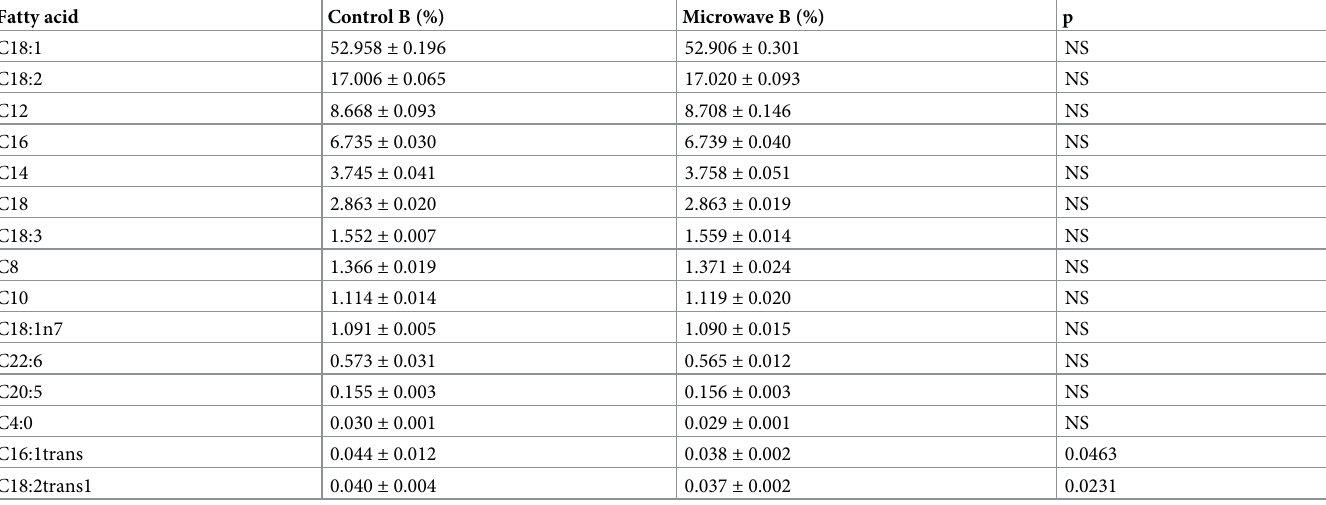
Fatty acids representing > 0.5% of total are presented, as well as the eicosapentaenoic acid (EPA) and other fatty acids, for which differences were found. The complete data are presented in S2